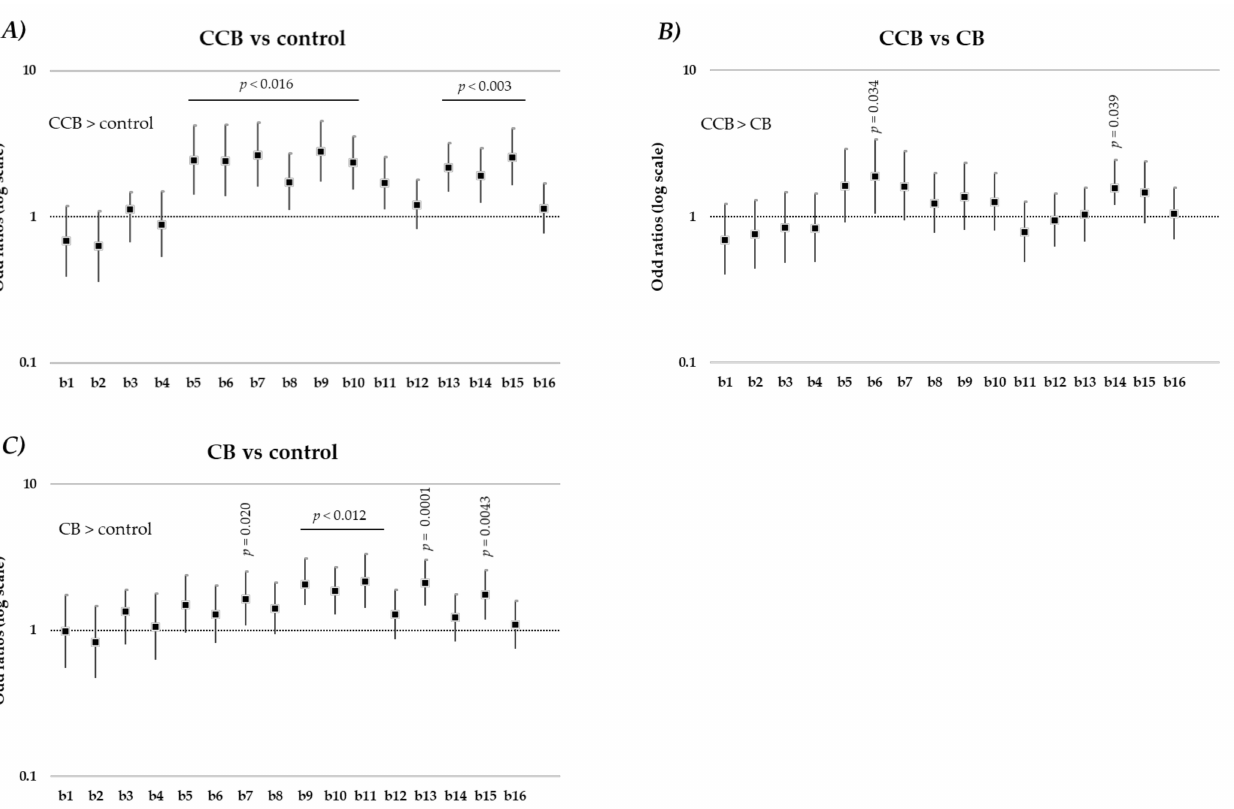
Figure 2. Odds ratios and 95% confidence intervals for product-effect differences on SAT accuracy for the 16 experimental blocks following product intake. Pairwise comparisons for accuracy are shown separately for carbonated caffeinated beverage and control beverage ( A ); carbonated caffeinated bev- erage and caffeinated beverage ( B ); caffeinated beverage and control beverage ( C ). CCB = carbonated caffeinated beverage; CB = caffeinated beverage; b =